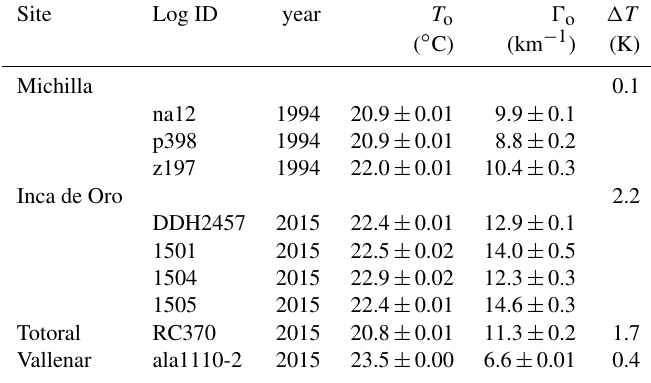
Table 2. Summary of inversion results where T o is the long-term surface temperature, (cid:48) o is the quasi-steady-state temperature gradient, and (cid:49)T is the difference between the maximal temperature and the temperature at 1500 years